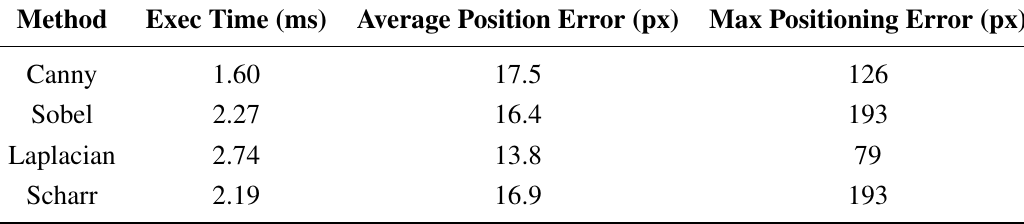
Table 2. Performance evaluation of edge detectors for line